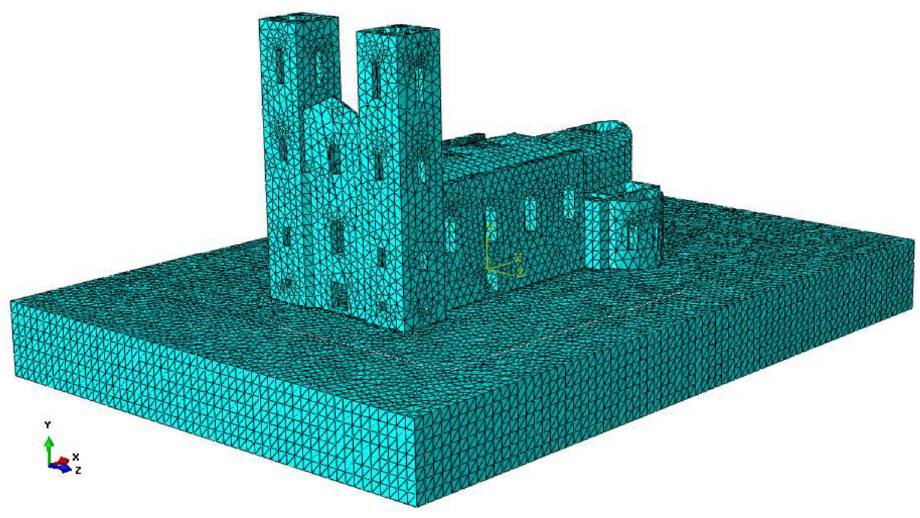
Figure 12. FE mesh of the Cathedral numerical model with the surrounding soil.